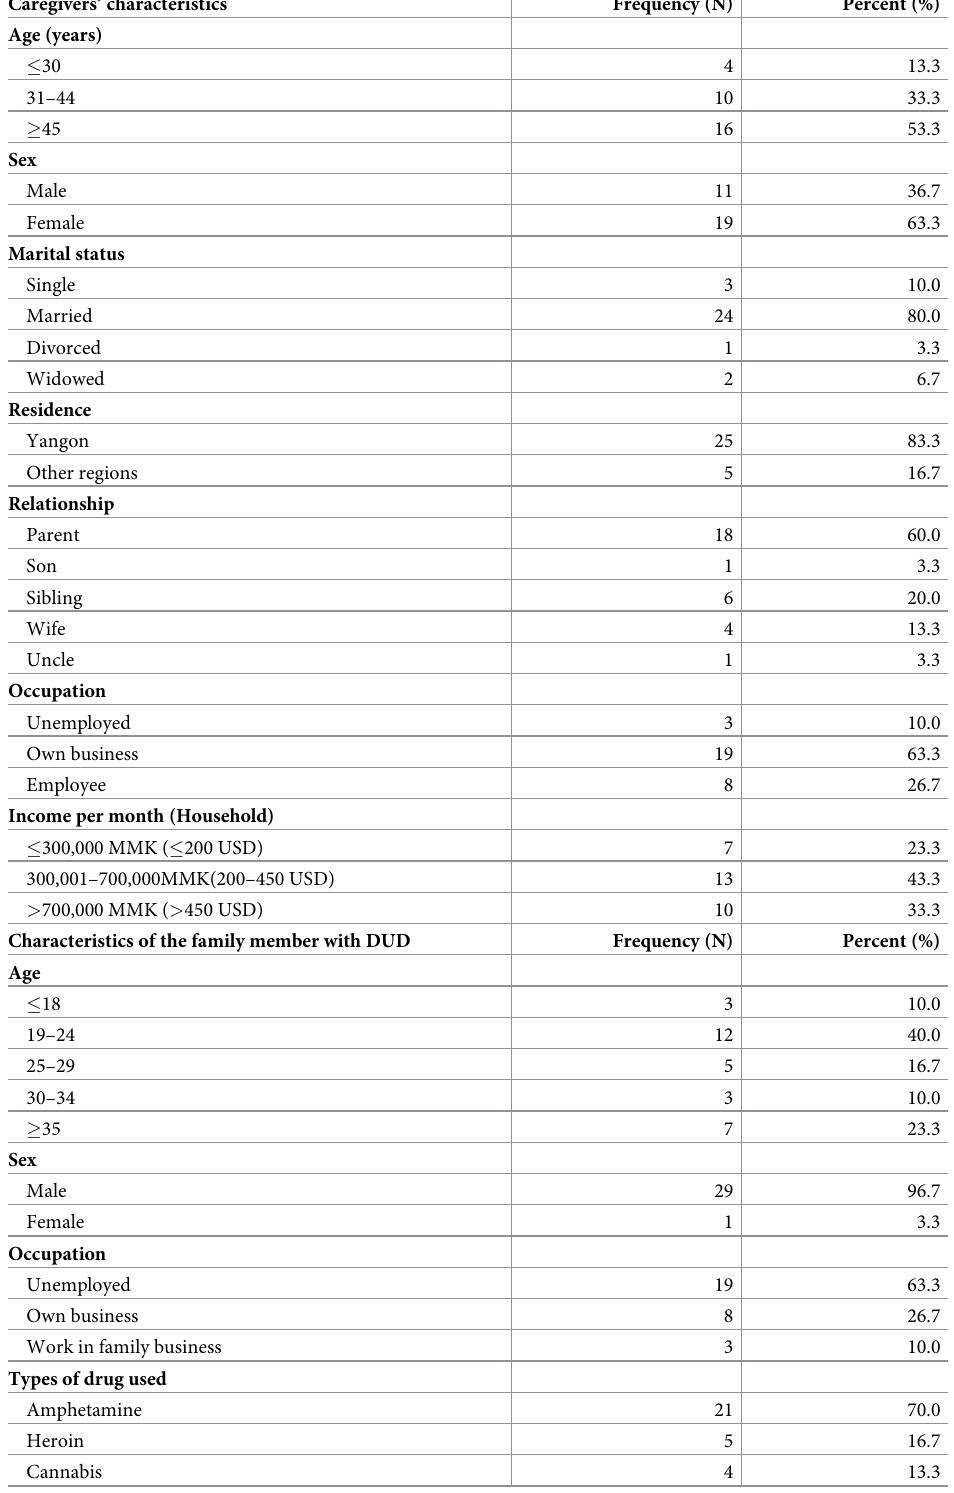
Table 1. Socio demographic characteristics of caregivers and their family